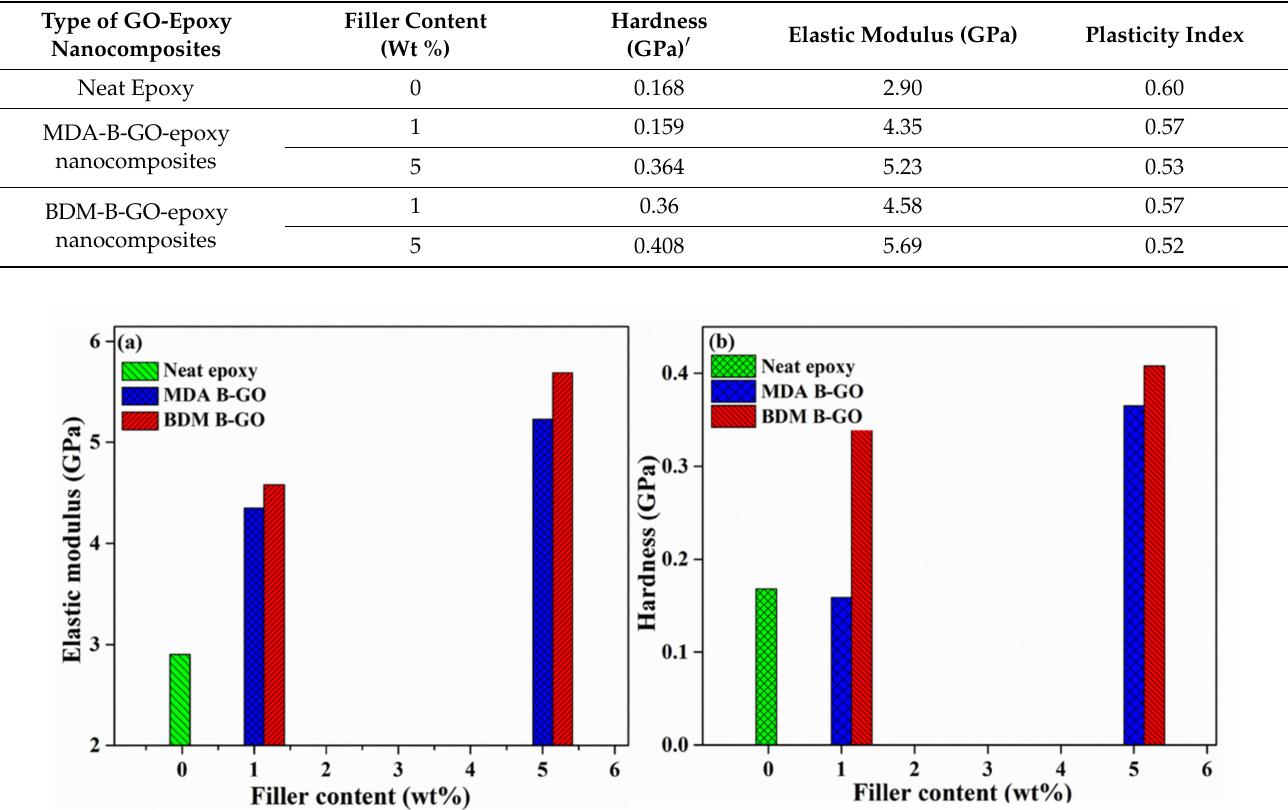
Figure 12. ( a ) Elastic modulus and ( b ) Hardness of neat epoxy and its